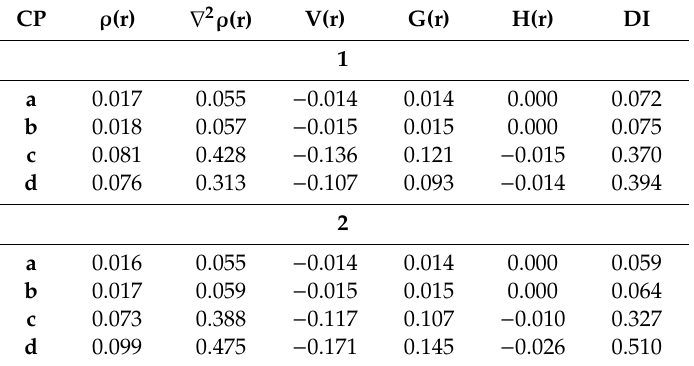
Table 2. Electron charge density ( ρ ), its Laplacian ( ∇ 2 ρ ), kinetic (V), Lagrangian (G) and total (H) energy densities at the bond critical points (CPs) labelled in Figure 5 for compounds 1 and 2 in a.u.